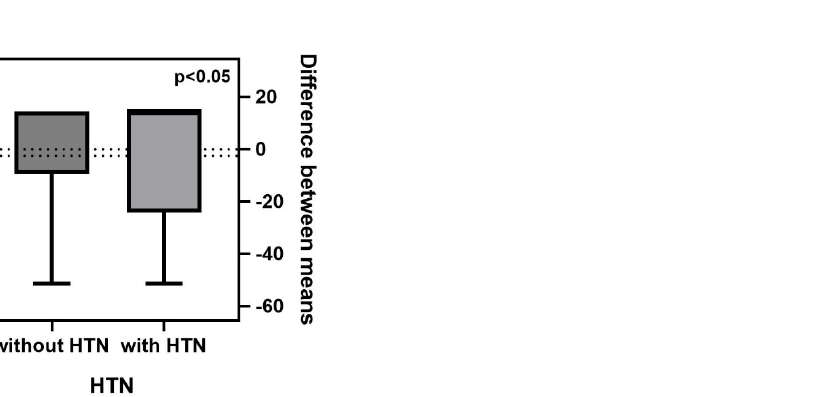
Table 3. A multiple regression analysis evaluating meiboscores as dependent variable.